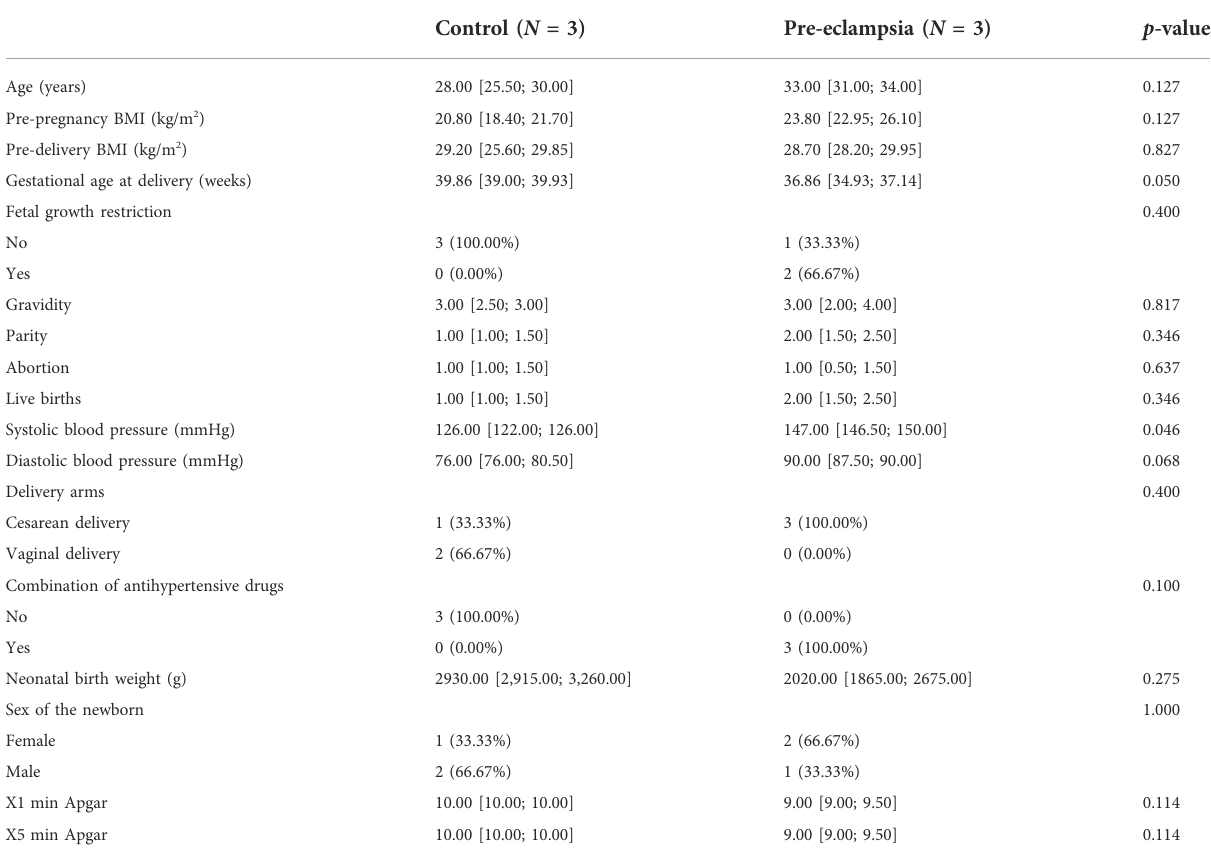
TABLE 1 Baseline characteristics of study